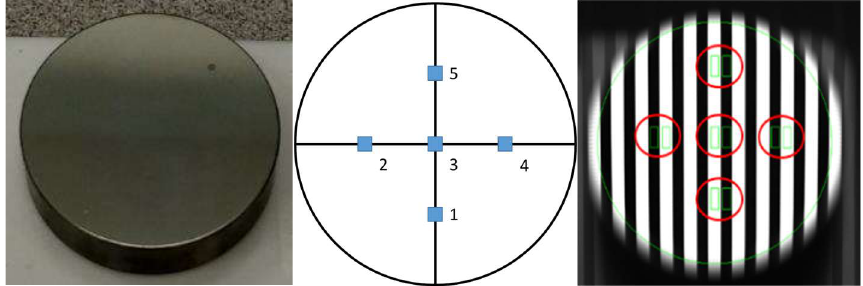
Figure 7. Measured areas on the coupon surface.